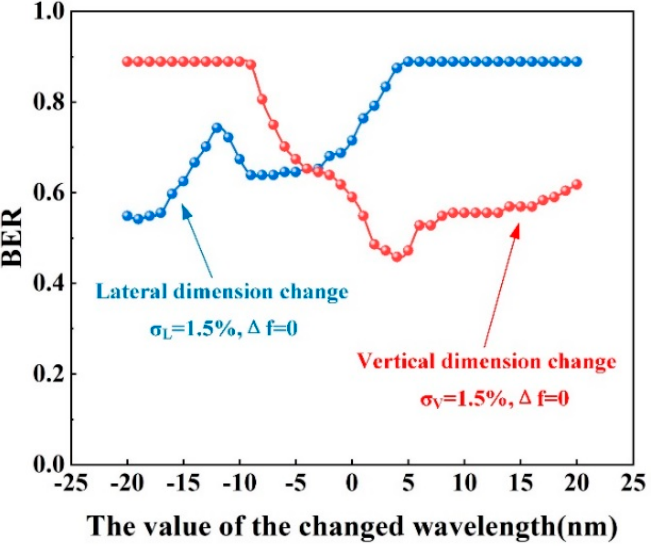
Figure 5. The BER with different wavelength adjustments of the reading light for the lateral dimension change condition ( σ L = 1.5%) and the vertical dimension change condition ( σ V = 1.5%) when the focal length of the objective lens was unchanged.